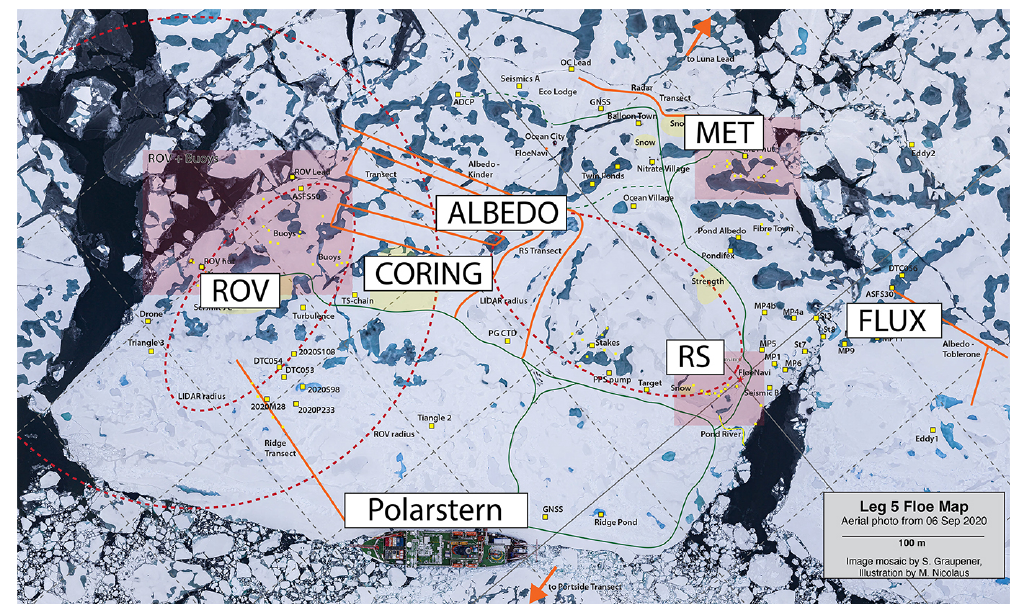
Figure 1. Aerial photo showing the location of R/V Polarstern (bottom center) relative to the position of the remote sensing (RS) site (middle right of image). Also shown are the locations of MET City, where the meteorological observations used in this study were obtained (upper right of image), and the remote sensing and the albedo transects (center of image). MET City was ∼ 100m from the RS site. The floe was located at roughly 89 ◦ N, 109 ◦ W. Snow pit areas are highlighted in yellow. RS and MET City as well as the ROV and buoy sites are highlighted in